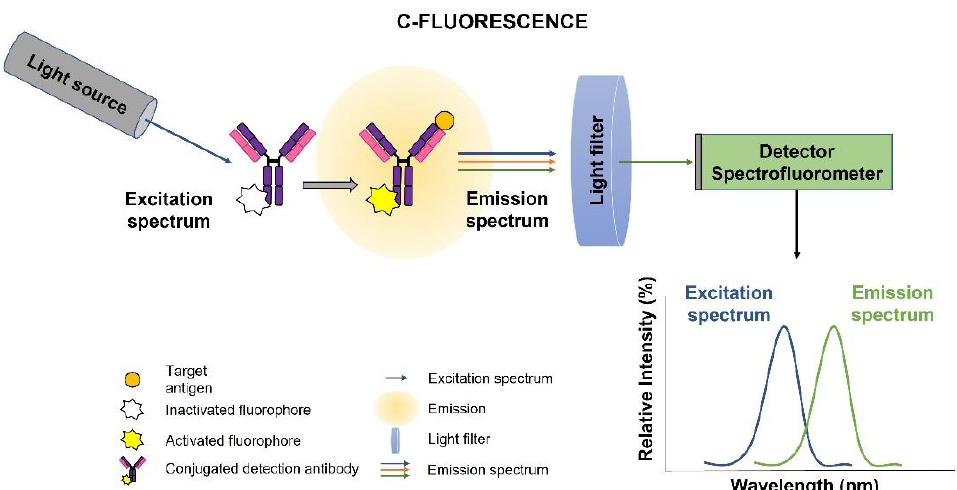
Figure 12. Fluorescence technique scheme to detect an antigen. The optical setup comprises a light source, a light filter and a spectrofluorometer.